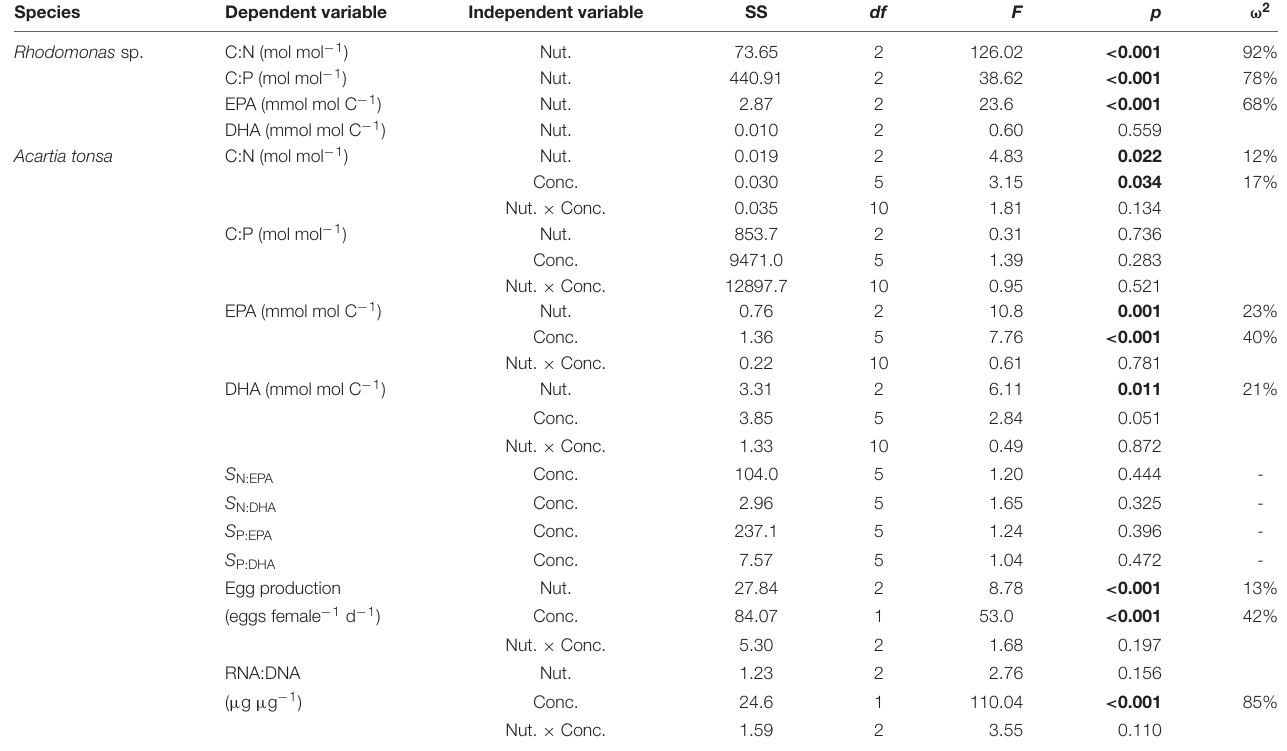
TABLE 2 | Summary of ANOVA on the responses of C:N, C:P, and the contents of EPA and DHA in Rhodomonas sp. to different nutrient treatments (Nut.), and C:N, C:P, EPA, DHA, the strength of limitation of deficient nutrient relative to essential fatty acids ( S N : EPA , S N : DHA , S P : EPA , and S P : DHA ), egg production rates and RNA:DNA in Acartia tonsa to different food quantity (Conc.; µ g C L − 1 ) and quality (Nut.). Species Dependent variable Independent variable SS df F p ω 2 Rhodomonas